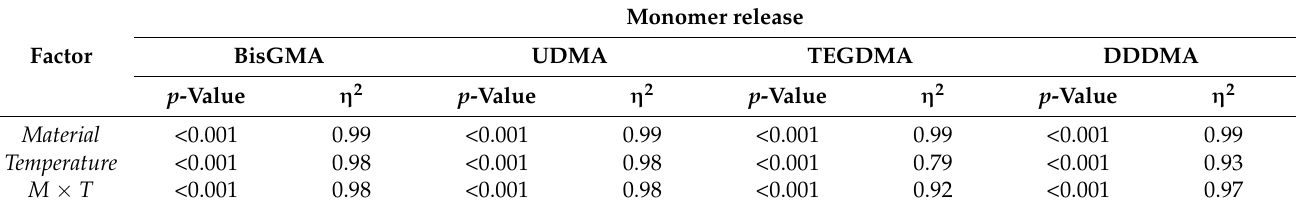
Table 2. Relative effect size of Material ( M ) and Temperature ( T ) factors and their interaction ( M × T ) on the amounts of released monomers. The general linear model and partial eta-squared statistics ( η 2 ) show a large and significant effect of both the type of resin composite ( M ) and pre-polymerization temperature ( T ) and their interaction on the release of those monomers that can be found in more resin